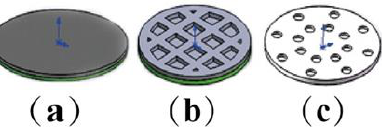
Figure 2. The models of oral films: ( a ) solid sample, ( b ) hollow grid, ( c ) concentric holes. Table 5. The parameters of 3D printing.